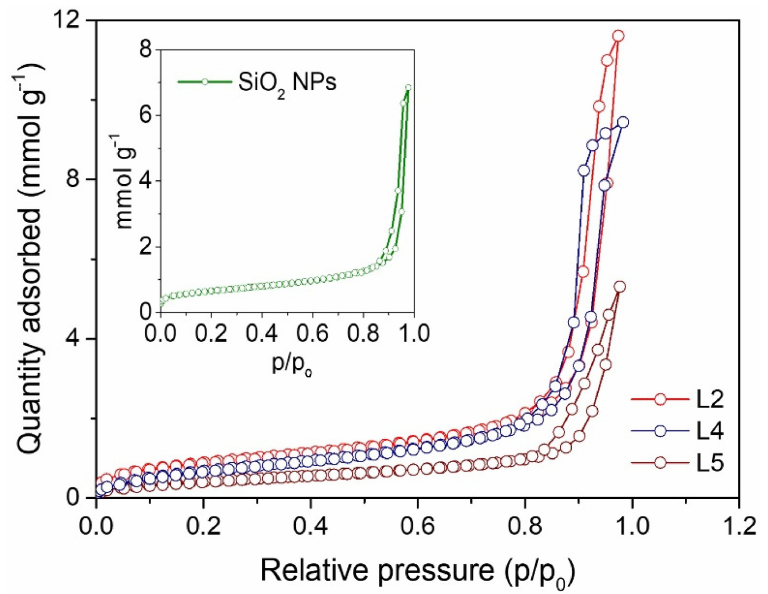
Figure 3. The nitrogen adsorption/desorption isotherms for the SiO 2 NPs (inset) and modified SiO 2 NPs with L2 , L4 , L5_acid